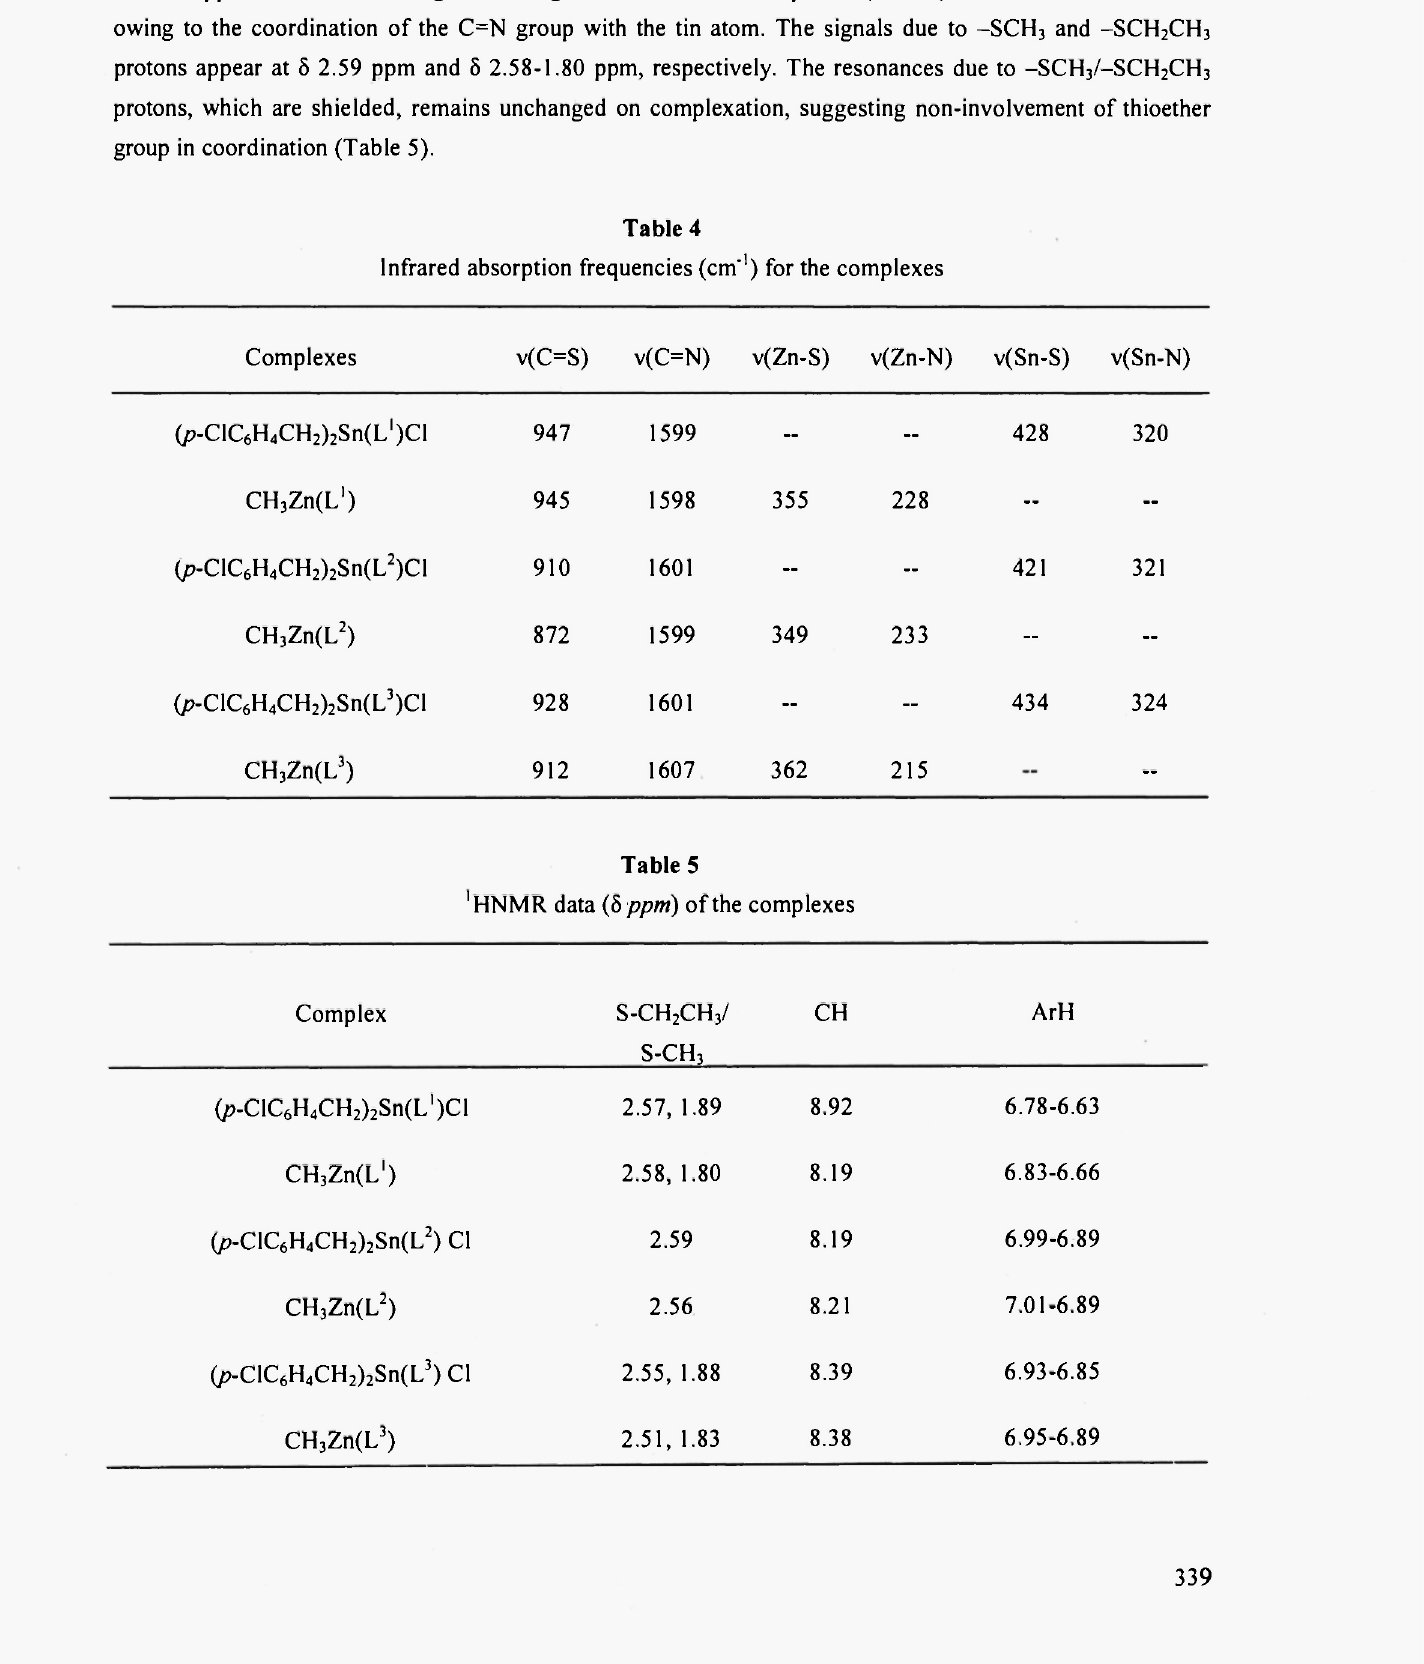
'HNMR data (δ ppm) of the